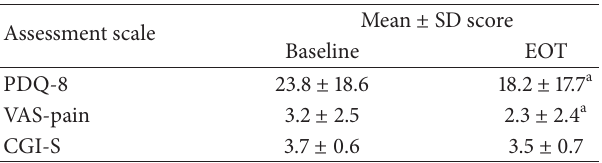
Figure 1: Change in PDSS-2 total score and domain scores from baseline after 3 months of nightly treatment with rotigotine trans- dermal patch in the efficacy population ( 𝑛 = 74 ). EOT, end of treatment; SD, standard deviation. ∗ 𝑝 < 0.001 versus baseline. Table 2: PDQ-8, VAS-pain, and CGI-S scores at baseline and after 3 months of months of nightly treatment with rotigotine transdermal patch in the efficacy population ( 𝑛 = 74 ).